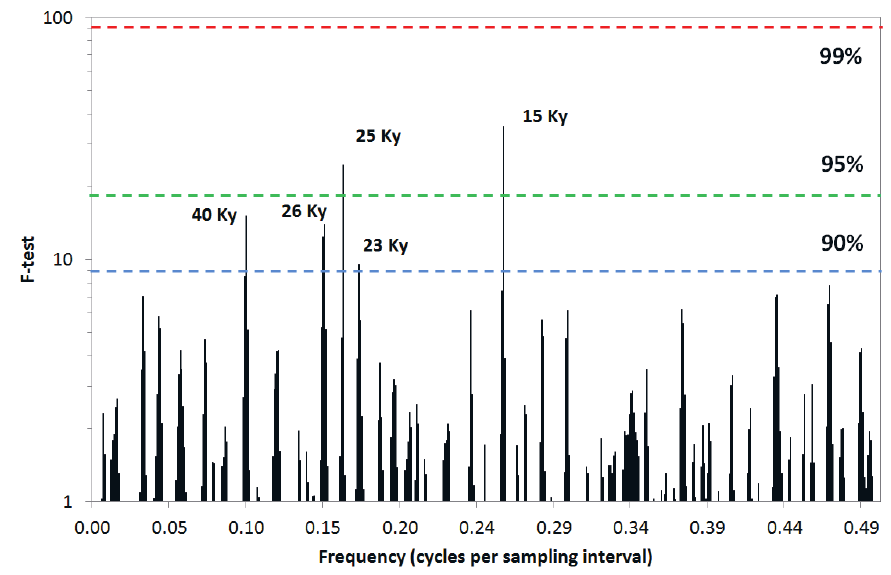
Figure 10. Statistical confidence levels of the power spectrum shown in Figure 9, calculated which corresponds to a period of 8